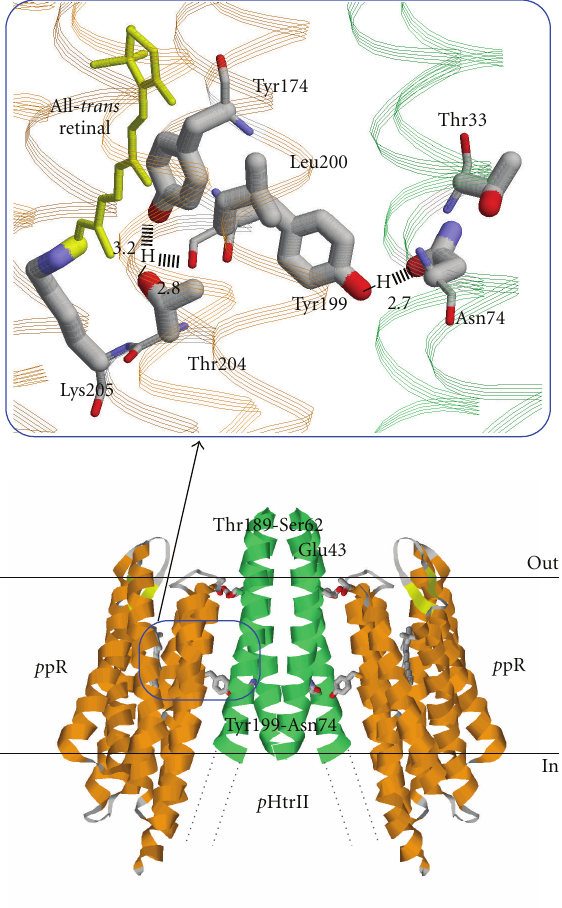
Figure 2: (The upper region) X-ray crystallographic structure of the complex between p pR and p HtrII (PDB code, 1H2S) [29]. (The lower panel) Details of the X-ray crystallographic structure of the p pR/ p HtrII complex [29] focusing on specific hydrogen bonds. Hydrogen bond between Tyr199 of p pR and Asn74 of p HtrII, whose distance is 2 . 7 ˚A, and hydrogen bond between Tyr174 and Thr204 in p HtrII, whose distance is 3 . 2 ˚A, are shown. (F) and (G) helices of p pR that involve Tyr174 and Thr204, respectively, are sandwiched by the retinal chromophore and TM1 and TM2 helices of p HtrII.